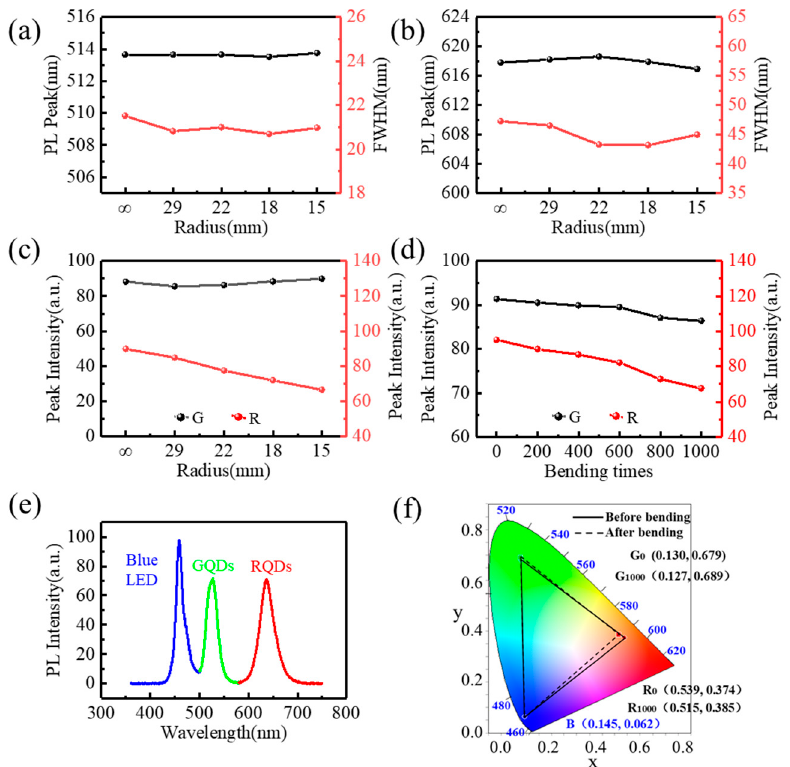
Figure 6. Central wavelength and FWHM variation curves at different bending radii of ( a ) green FQCL and ( b ) red FQCL. ( c ) Peak intensity variation curves of green and red FQCL at different bending radii. ( d ) Peak intensity variation curves at different bending times of green and red FQCL. ( e ) Full-spectrum curve of red, green, and blue. ( f ) Color gamut diagram.